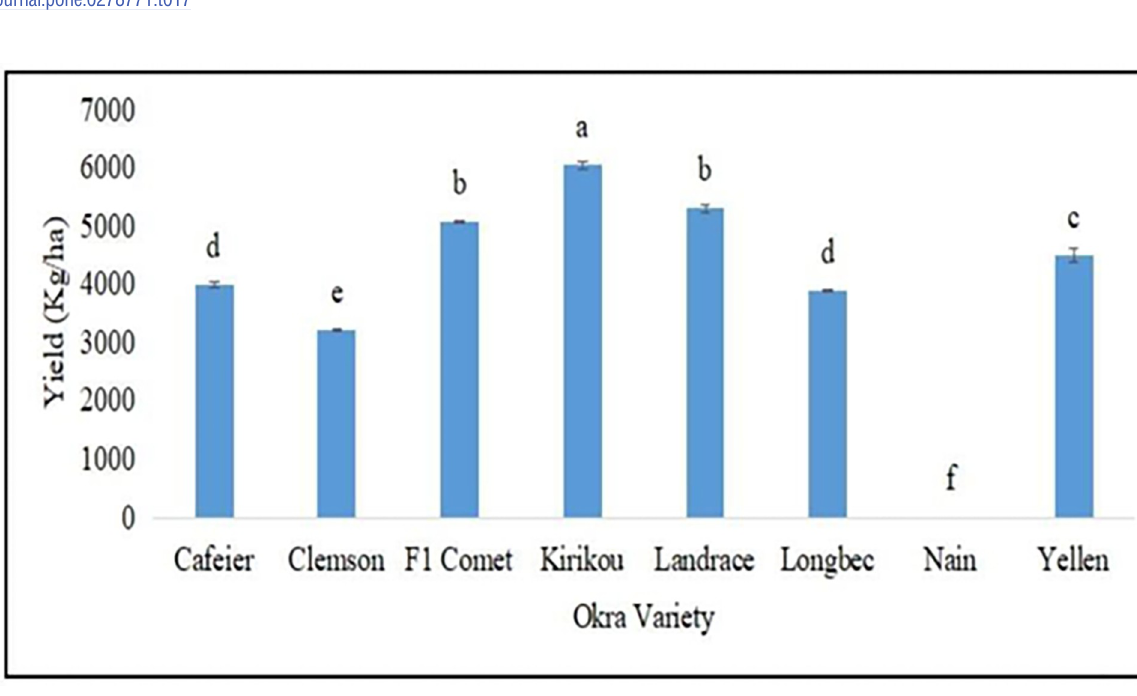
Fig 2. Yield of okra cultivars planted in Buea, Cameroon